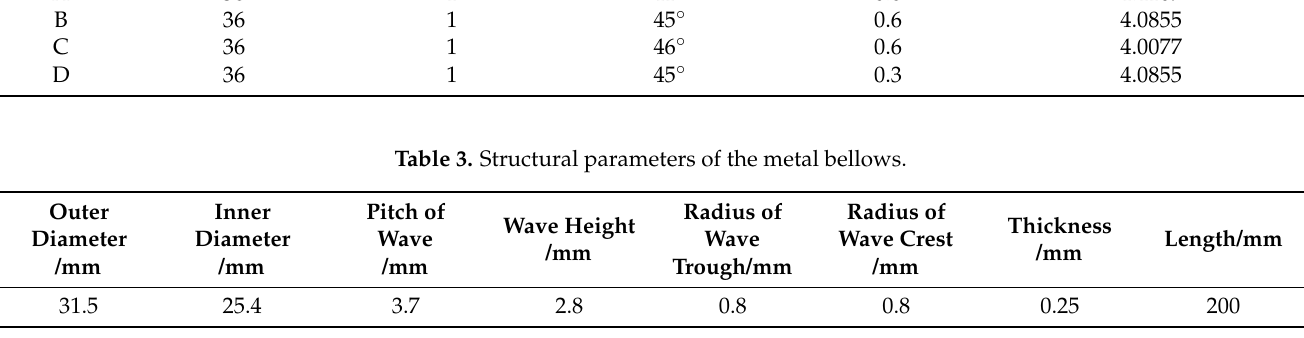
Figure 10. Experimental boundary conditions. 3.3. Numerical Results and Analysis It can be seen from Figure 11 that the stretching deformation of the braided corrugated hose occurs in three stages. The first stage is linear stage, involving very little displacement. At the beginning of the stretching period, the metallic braided tube undergoes slight axial deformation. The axial stiffness of the braided corrugated hose is mainly provided by the metal bellows. The second stage is the soft characteristic stage, with the increase in the tensile force, the deformation of the metallic braided tube occurs as the geometry transition. The diamond trellis changes from slight deformation (first stage) to large deformation, whereby the braiding angle also changes. During this process, the friction between the wires and the change of the braiding angle cause nonlinear phenomena. The third stage is also a linear stage. After the second stage, the diamond trellis and braiding angle do not change with increases in the tensile force. The elongation of the metallic braided tube mainly results from elongation of the metal wires under tensile force. The third stage is determined mainly by the characteristics of the wire. Figure 12 shows the axial stiffness values of the different braiding angles. It can be seen that the different braiding angles cause different levels of axial stiffness in the braided corrugated hose. The first stage of axial stiffness, involving different braiding angles, is almost the same. The greatest difference is in the second stage, whereby a critical braiding angle is assumed to exist between the second and third stages. When suffering under tensile force, a small braiding angle will achieve this critical braiding angle faster than a larger braiding angle and will enter the third stage earlier, meaning the axial stiffness will be larger than that with a larger braiding angle. When the diameter of the wire changes from 0.6 mm to 0.3 mm, the axial stiffness of the braided corrugated hose decreases significantly. This shows that the diameter of the wire is also an important factor affecting the nonlinear phenomenon.